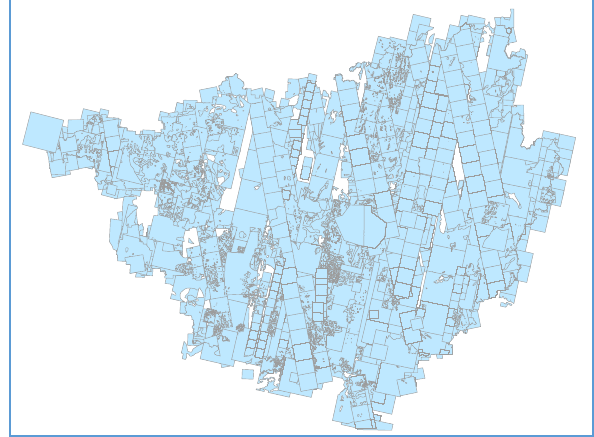
Figure 3. Store images of year 2018, month